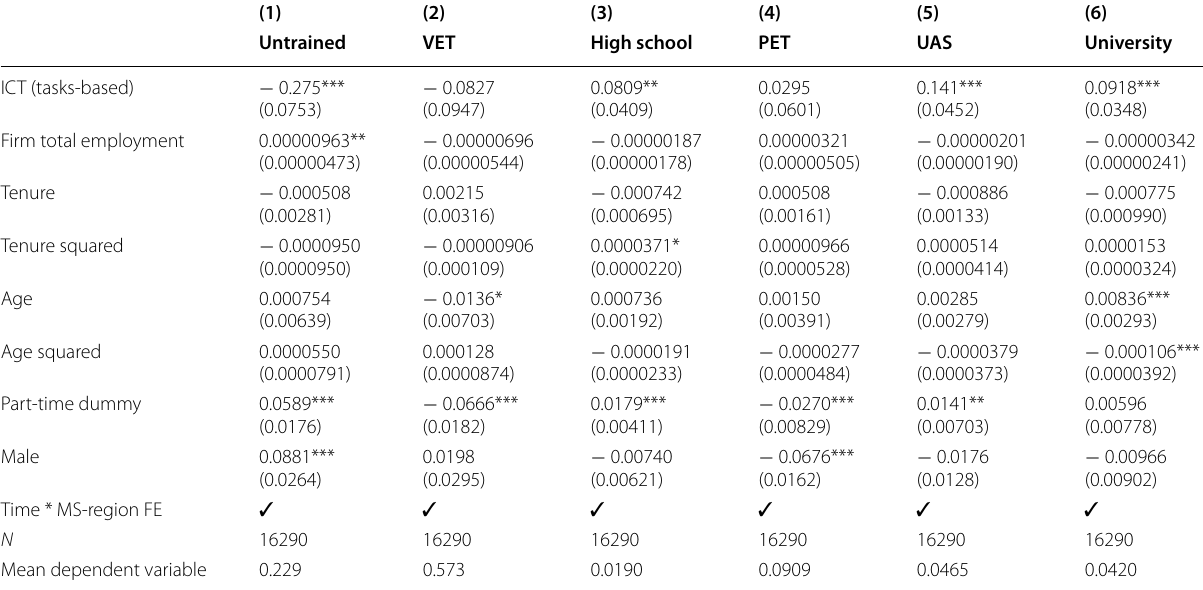
The table shows the GMM estimates of a firm pseudo-panel with cells defined according to MS-region, industry, and firm size. Standard errors in parentheses are clustered at the cell level. N reports the number of pseudo-panel cells that contain at least one firm. The main explanatory variable measures the cell percentage of ICT workers according to ICT tasks. Estimates further control for time*MS-region fixed effects and cell averages of total employment, tenure, age, part-time status, and gender. Each column shows the results for a different dependent variable measuring the percentage of workers with a particular education within the